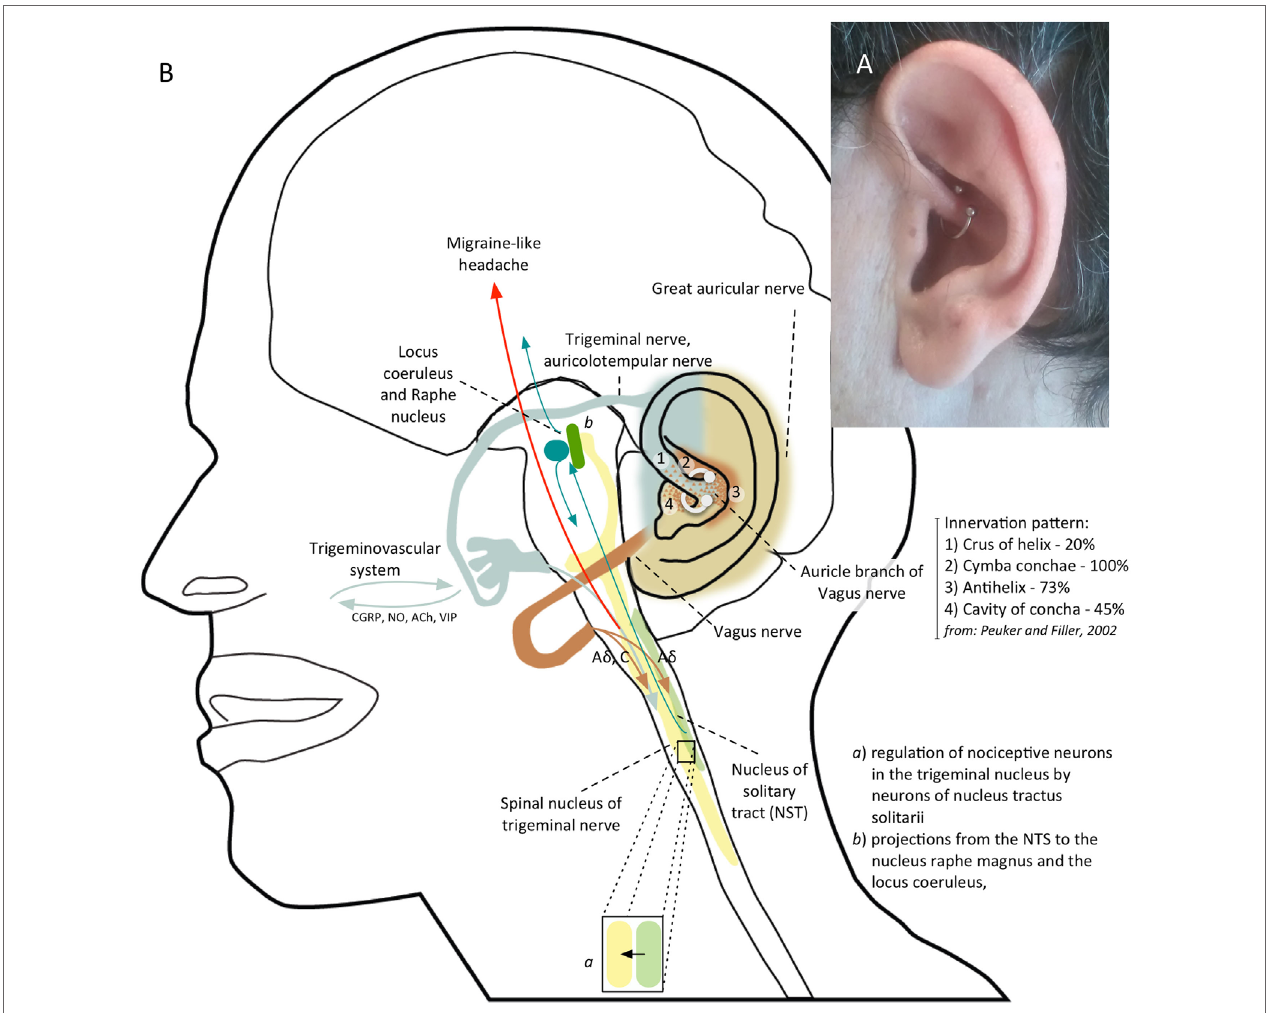
FiguRe 2 | (a) Patient’s left ear with daith piercing located at the crus of the helix. (B) Shows the possible mechanism of action of daith piercing: a nociceptive sensory stimulus provided by daith piercing activates vagal afferents which, through the nucleus tractus solitarii (NTS), exert an inhibitory action on neurons in the caudal trigeminal nucleus; vagal activation can also modulate pain perception by means projections from NTS to the locus coeruleus and to the nucleus raphe